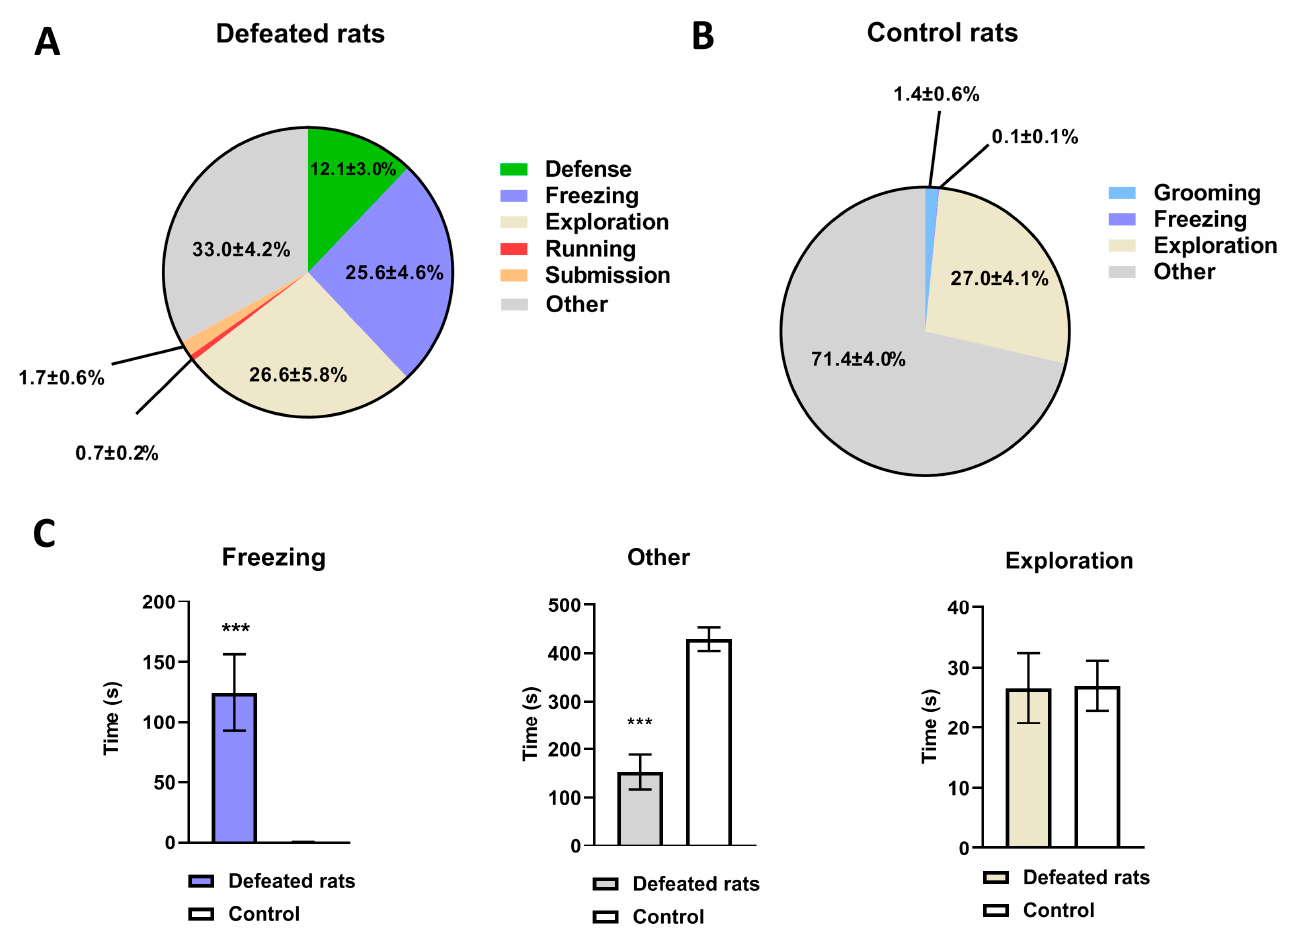
Figure 2. Rat behavior displayed during social defeat stress. Behaviors were characterized as defensive, freezing (rat does not move), explorative (rearing and sniffing), running, submissive (rat lying on the back), or other (walking, standing). ( A )–Distribution of behaviors exhibited by intruder rats during social defeat stress presented as a percent of total session time exposure (n = 8), (mean ± SEM). ( B )–Distribution of behaviors exhibited by intruder “control” rats during a 20 min exposure to a non-aggressive counterpart presented as a percent of total session time (n = 8), (mean ± SEM). ( C )–Effect of social defeat stress on the display of select behaviors compared to non-stressed controls. Data presented as mean ± SEM, Unpaired two-tailed t -tests or Mann–Whitney U test was used, (n = 8 per group), *** p ≤ 0.0006.